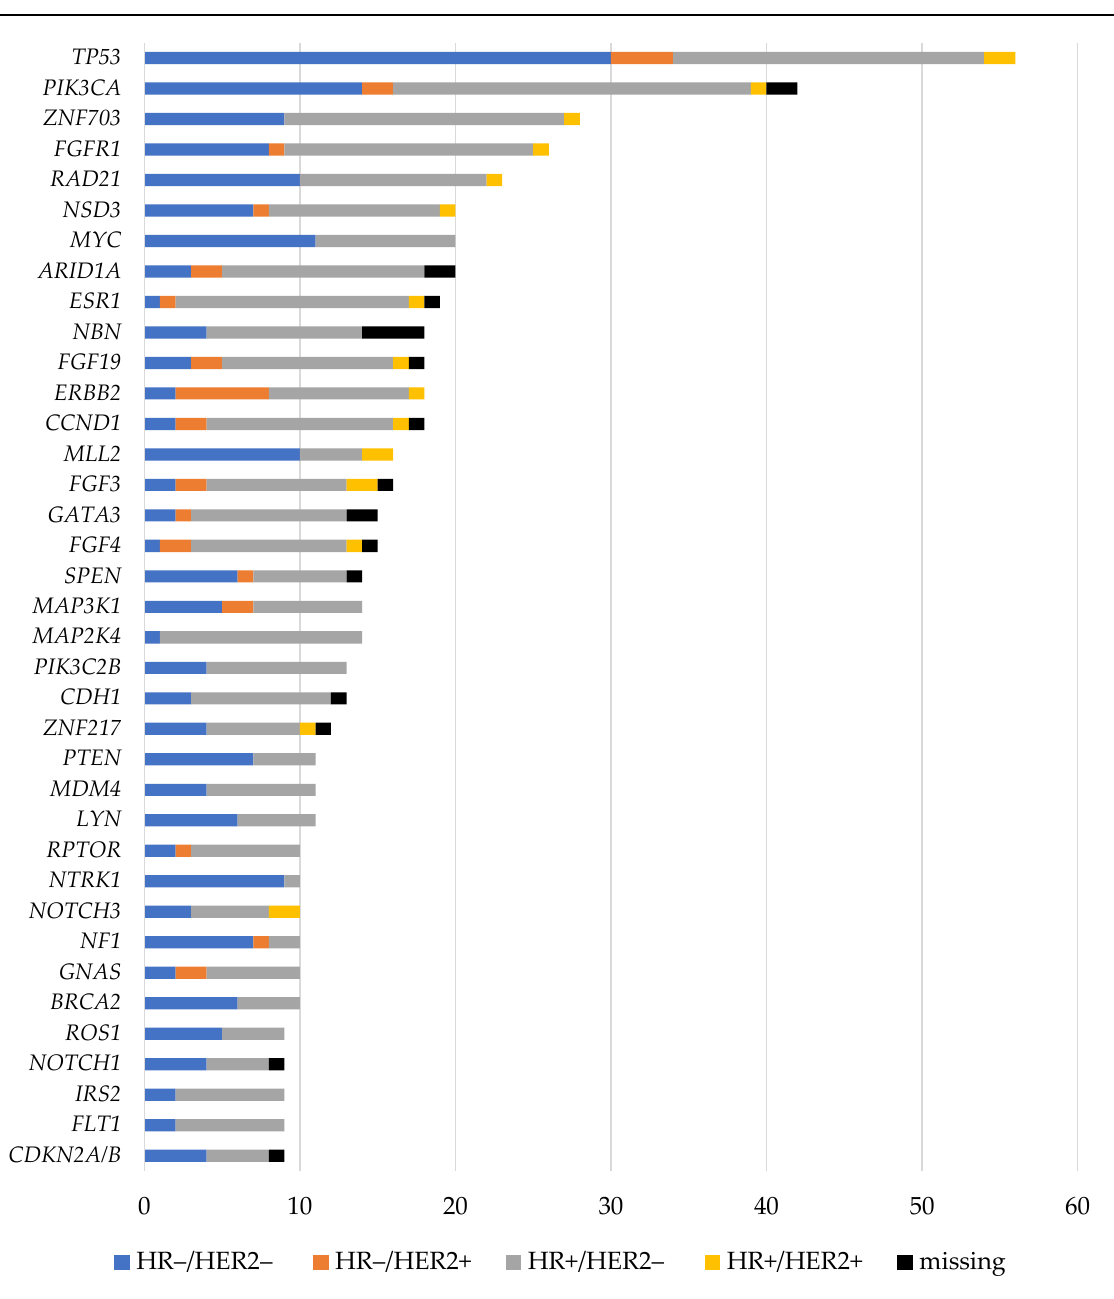
Figure 1. Genes that were altered ≥9 times in a cohort of 95 patients with metastatic breast cancer according to the tumor receptor subtype of the specimen subjected to genotyping. HER2, human epidermal growth factor receptor-2; HR, hormone receptor.